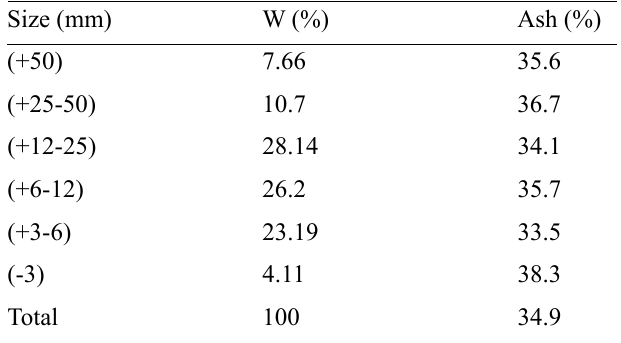
Table 1. Gradation and middle ash of the tri-flo separation in